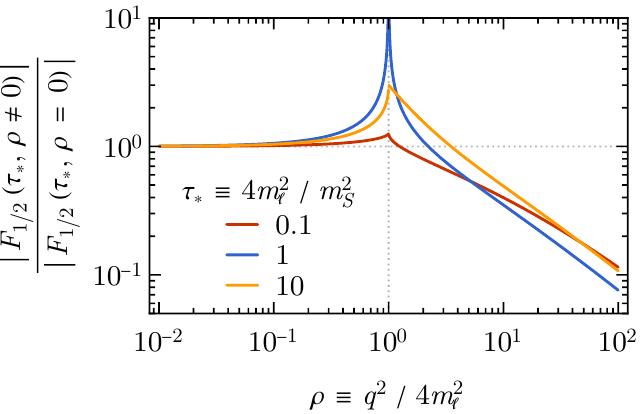
with an o(cid:11)-shell ( (cid:26) 6 = 0) 1 = 2